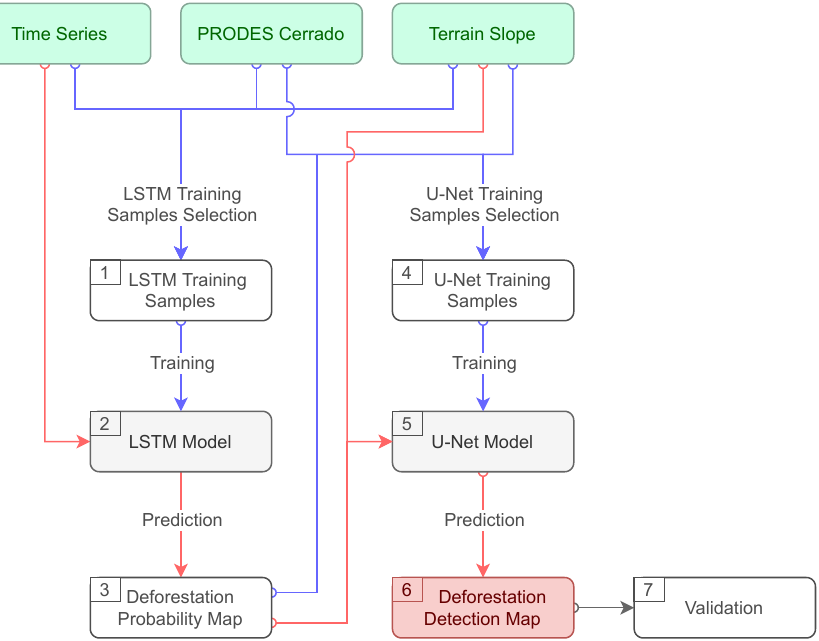
Figure 2. Flowchart to describe the deforestation detection methodology. Rectangles: the input data, DL models, and final results are colored in green, gray, and red, respectively. The numbers indicate their order in the flowchart. Connections: operations regarding the models training, operations related to using the trained models to predict over data, and operations of validation are colored in blue, red, and gray,